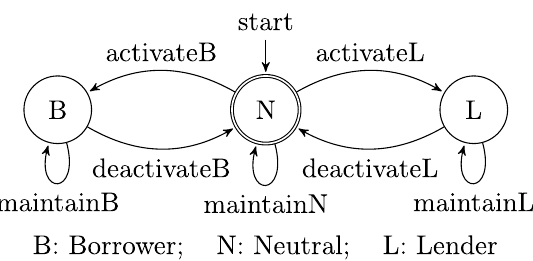
Fig. 3 State machine of the memory sharing system